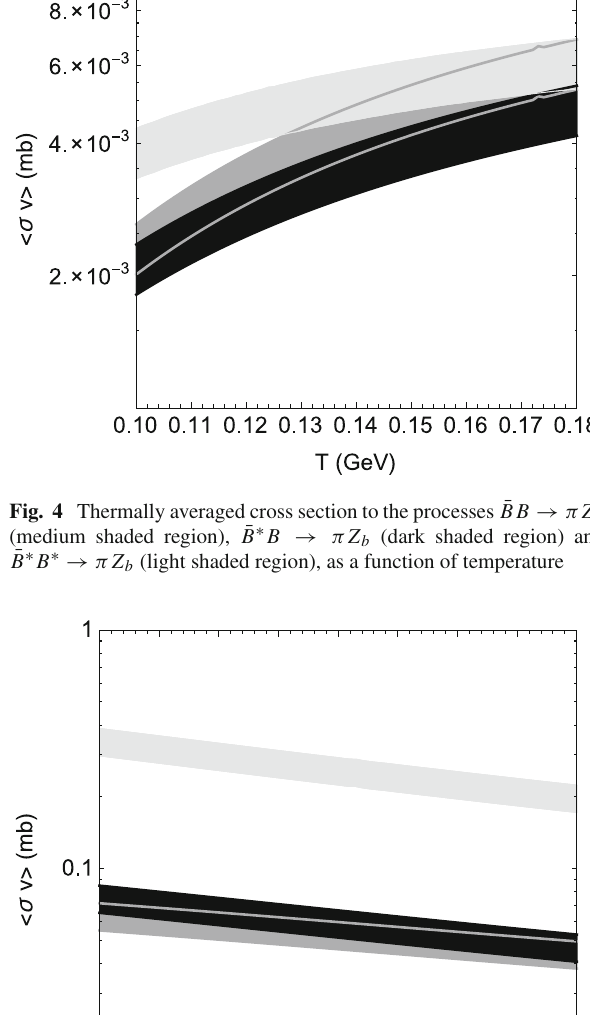
cially at high temperatures. The absorption processes with ¯ ¯ B final states have comparable cross sections B B and B ∗